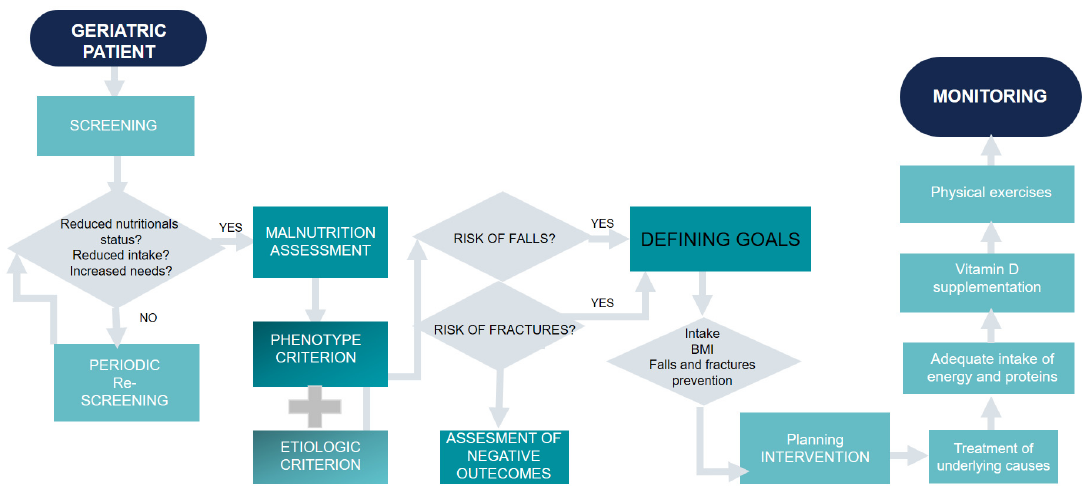
Figure 1. A summary of recommendations for malnutrition, fall, and fracture